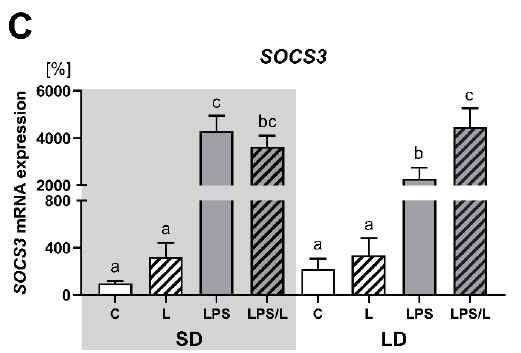
Figure 2. Mean (±SEM) mRNA expression of LEPRa ( A ), LEPRb ( B ) and SOCS3 ( C ) in the ovine choroid plexus of saline (C, control—white bars), saline–leptin (L, white hatched bars), LPS (grey bars) and LPS–leptin (LPS/L, grey hatched bars) treated ewes during the short-day (SD, dark background) and the long-day (LD, light background) photoperiods. Different lowercase letters indicate significant differences between all groups at p < 0.05 (two-way ANOVA—Tukey’s post hoc test). The results are presented as percentage values (%), where the SD C group is considered as 100%.